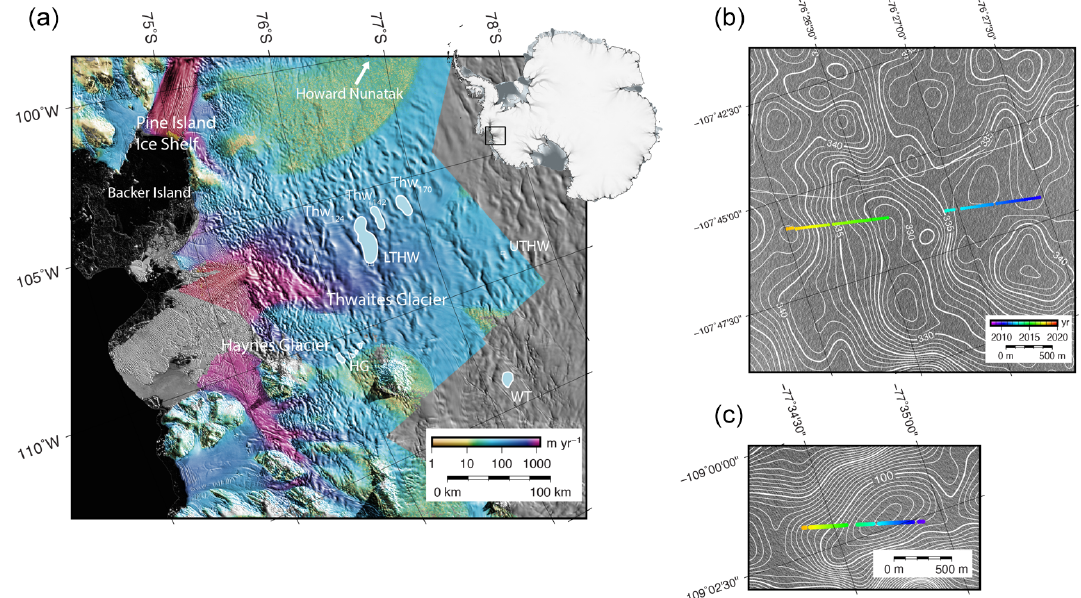
Figure 1. Location map of Thwaites Glacier and subglacial Thwaites lakes. (a) Average ice speed between 2015–2019 omitting period when lakes were active (color) plotted over Moderate Resolution Imaging Spectroradiometer (MODIS) image mosaic (Haran et al., 2014). Thwaites Glacier, Thwaites Lake 124 (Thw 124 ), Thwaites Lake 142 (Thw 142 ), Thwaites Lake 170 (Thw 170 ), Haynes Glacier (HG) lake, western Thwaites (WT) lake and GNSS sites (LTHW and UTHW) are labeled. Thwaites lakes are named by their approximate distance from the grounding line. (b) LTHW and (c) UTHW GNSS position plotted over time (color) with contoured mean velocity between